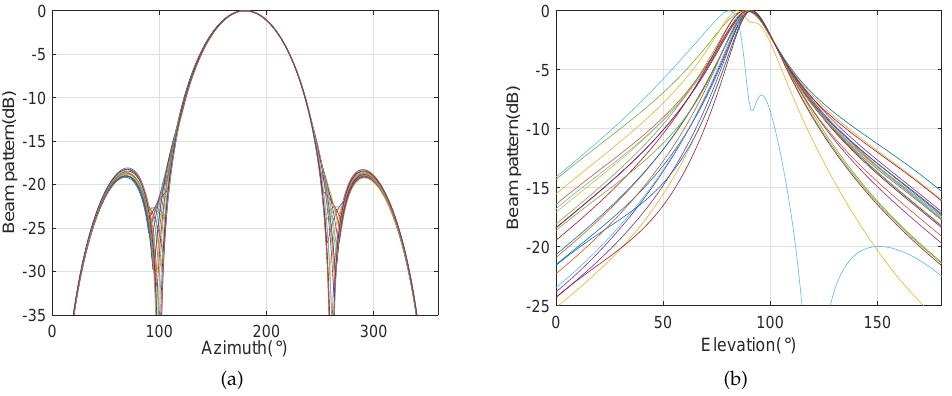
Figure 20. The beampatterns on the azimuth and elevation planes in the presence of steering vector error, where the amplitude of the error is equal to 0.01. ( a ) Beampattern on the azimuth plane; ( b ) beampattern on the elevation